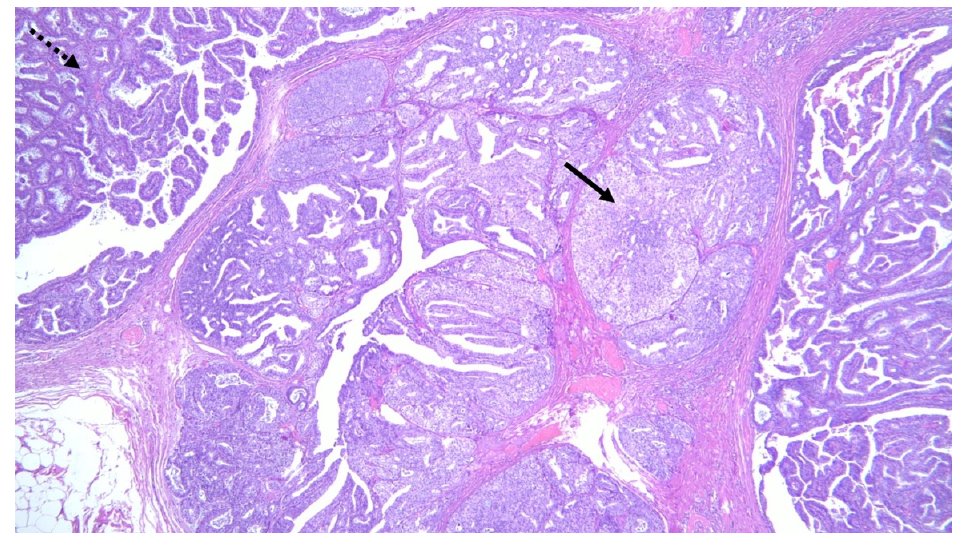
Figure 7. Histologic section showing multiple papillomas composed of a fibrovascular core covered with ductal epithelial and myoepithelial cells (dotted arrow) combined with foci of intraductal carcinoma (solid arrow).